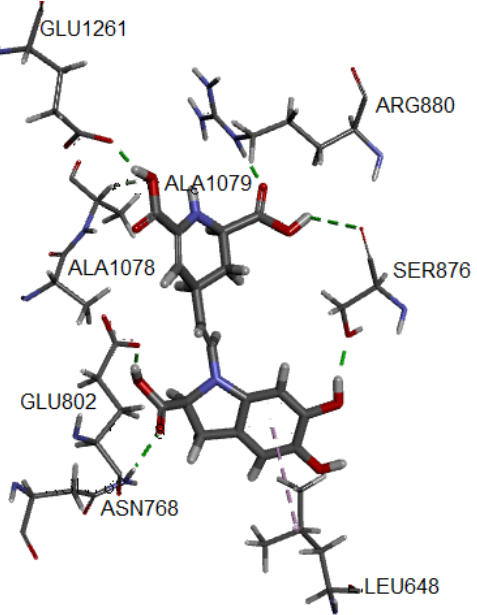
Figure 4. Hydrogen bonds and alkyl interactions of IsoBd with XO obtained from MD study. The hydrogen bond correspond to the residues Glu1261 (1.741 Å), Arg880, (1.696 Å), Ala1079 (2.364 Å), Glu802 (1.592 Å), Ser876 (3.055 Å) and Asn768 (2.045 Å). On the